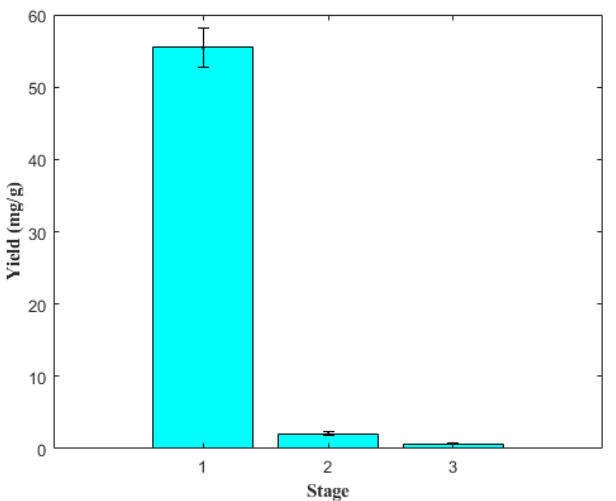
Figure 5. Yields of 5-CQA per extraction stage.